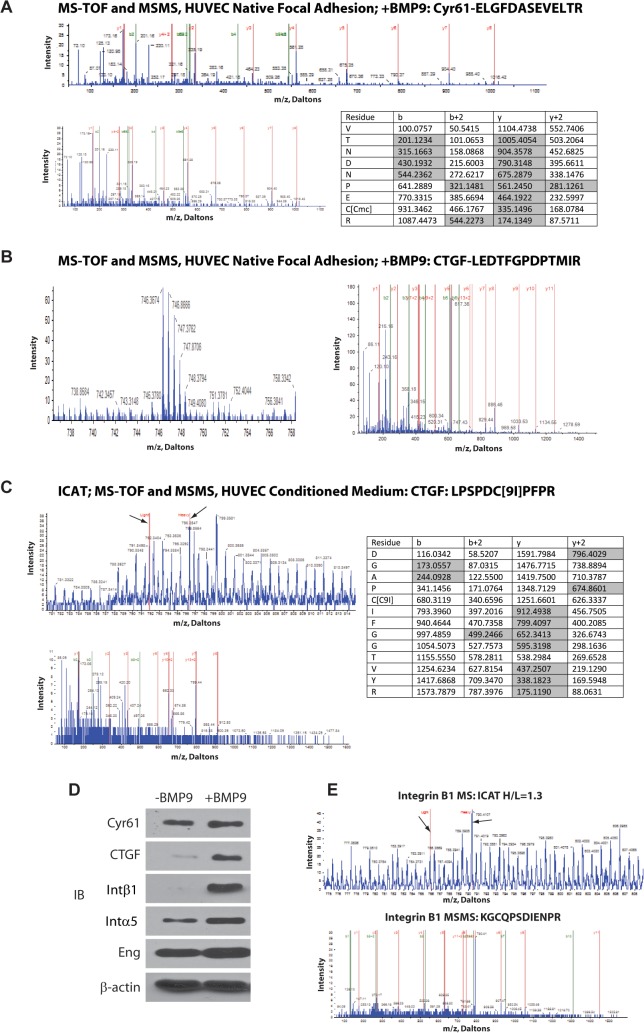
Mass spectrometric analysis suggests BMP9-dependent CTGF and CYR61 secretion and focal adhesion localization.
(A-B) Survey spectra of BMP9-treated HUVEC focal adhesion preparations indicate the presence of CYR61 (A) and CTGF (B) proteins in focal adhesion fractions. MS identification and MSMS collision-induced decay sequence spectra are shown in the top and bottom spectra panels, respectively. Sequence data are presented in the table showing expected and observed ions (shaded) for this protein. (C) Isotope-coded affinity tag (ICAT) mass spectrometry of control and BMP9-treated and control HUVEC conditioned medium samples. Heavy isotope BMP9-treated and light isotope-tagged control peptide spectra are indicated with h or l, respectively. Left panels (A-C) are MS-TOF analyses for identification (A-C) and quantitation (C). (C) Left panel shows an example of heavy- (BMP9-treated) and light-isotope-tagged (control) CTGF peptide ICAT-labeled ions (arrows indicate ICAT-ions); right panels are MSMS-TOF collision-induced decay-based protein sequence analyses, used to identify the indicated peptides for CTGF. (D) Western blot analysis of HUVEC focal adhesion subcellular fraction for CYR61, CTGF, and integrins β1 and α5 proteins with or without BMP9 treatment. (E) Mass spectrometry ICAT analysis of the HUVEC focal adhesion subcellular fraction for integrin β1.